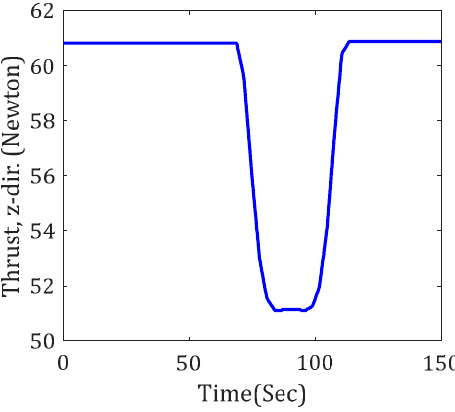
Figure 7. Prescribed variations of thrust in the compatibility scenario.